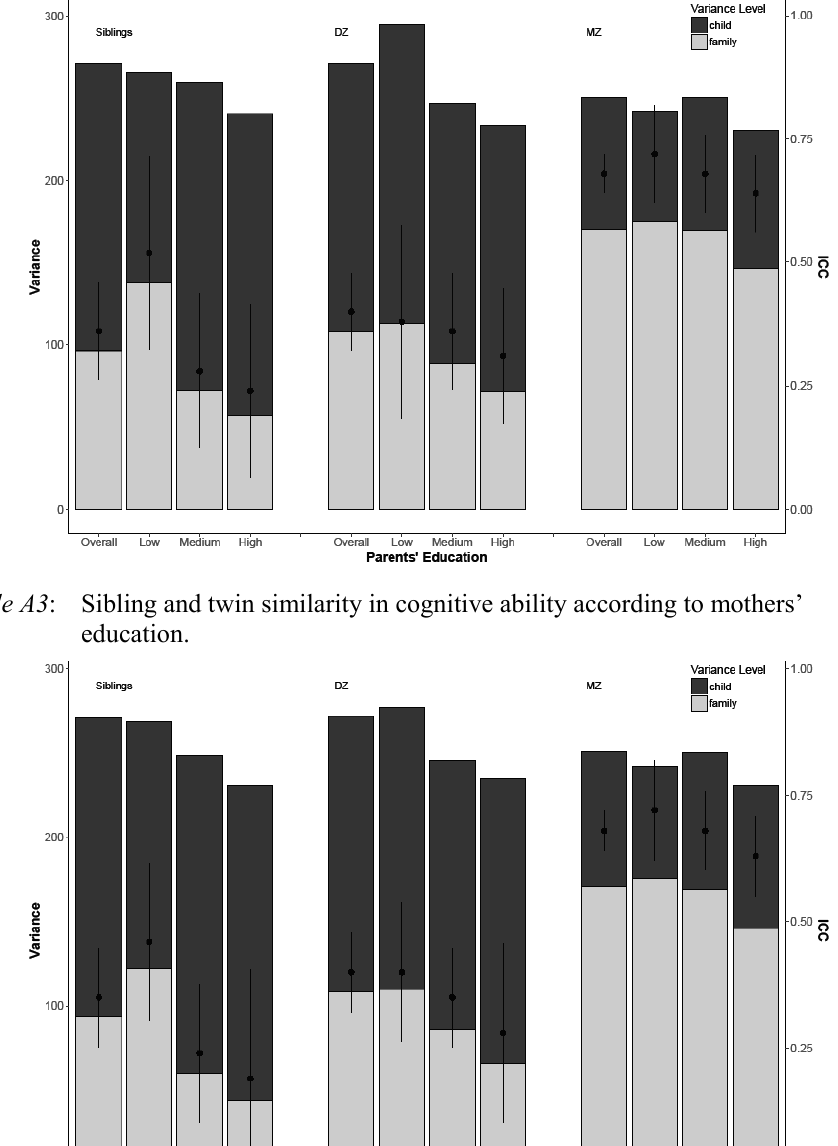
Table A2 : Sibling and twin similarity in cognitive ability according to parents’ education (controlled for siblings and twins closeness).